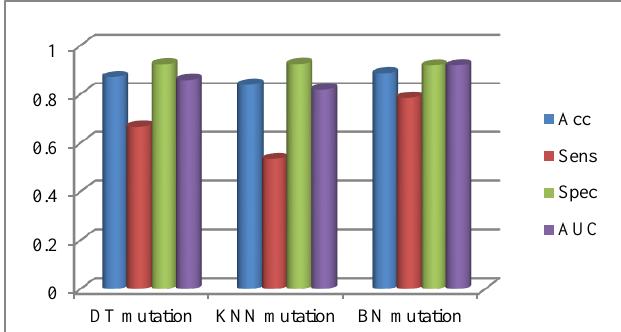
Figure 2. Missing value handling of three applied techniques (average of 18 model performance for each mutation).